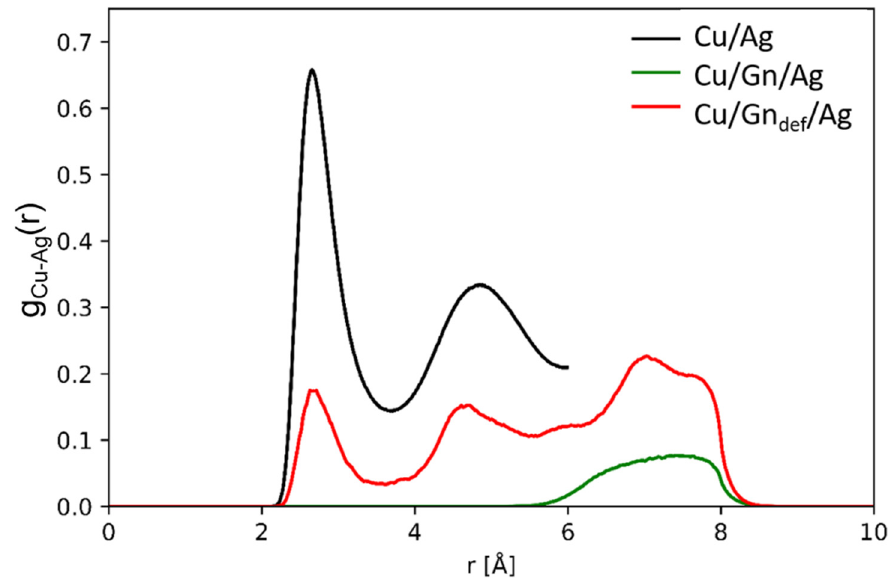
Figure 3. Radial distribution function for Cu-Ag atomic pair computed for Cu/Gn/Ag (green line) and Cu/Gn def /Ag (red line) at 500 ps. Results for Cu/Ag systems are added for comparison with an AgCu alloy formed upon reactive wetting of a pure Cu substrate by the liquid Ag droplet.